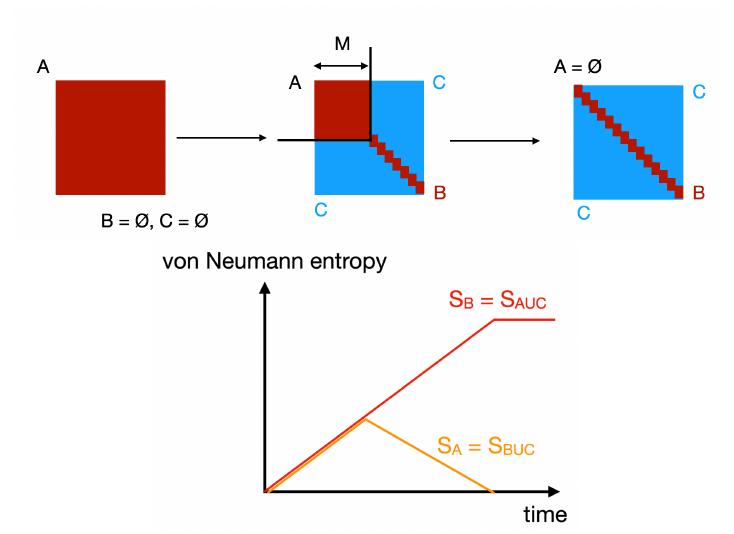
Figure 10 . Type IIA black zero-brane described by D0-brane matrix model (region A ) can ‘evaporate’ by emitting D0-branes (region B ) one by one. Black zero-brane is described by the M × M -block, where M decreases from N to 0 . At late time, off-diagonal elements shown by blue (region C ) decouple from the dynamics. However, they affect the calculation of the von Neumann